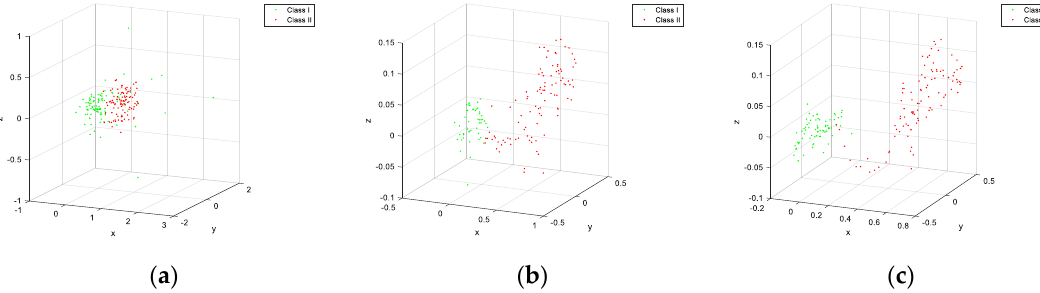
Figure 4. Neighborhood reconstruction results. ( a ) Original data distribution; ( b ) spatial neighborhood reconstruction distribution; ( c ) temporal neighborhood reconstruction distribution.